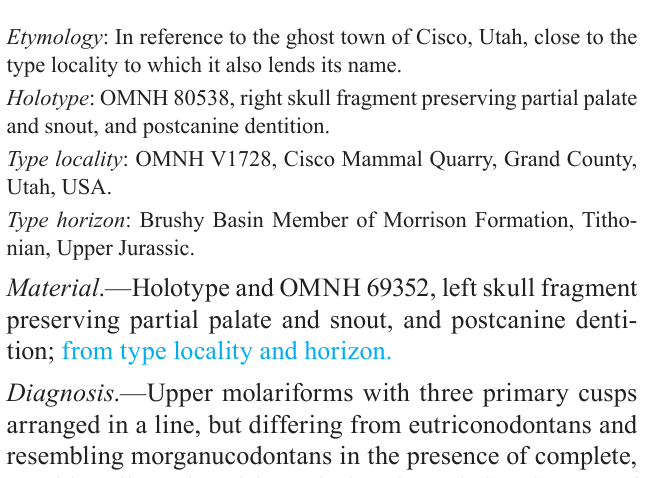
Fig. 1. 3D surface renderings from CT data of the morganucodontan mammaliaform Cifellilestes ciscoensis gen. et sp. nov. (OMNH 80538, holotype), from the Cisco Mammal Quarry, Utah, USA, Upper Jurassic Morrison Formation. A . Right skull fragment in lateral (A 1 ), medial (A 2 ), ventral (A 3 ), and dorsal (A 4 ) views. B . Dentition only in lingual (B 1 ), occlusal (B 2 ), and buccal (B 3 )